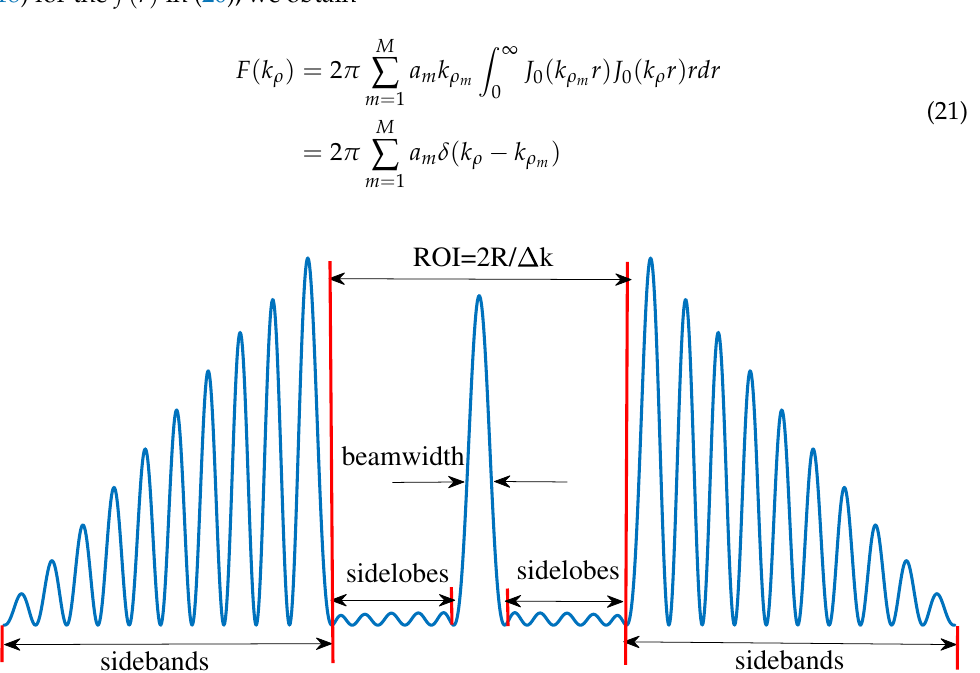
Figure 10. An example of the super-oscillatory point-spread